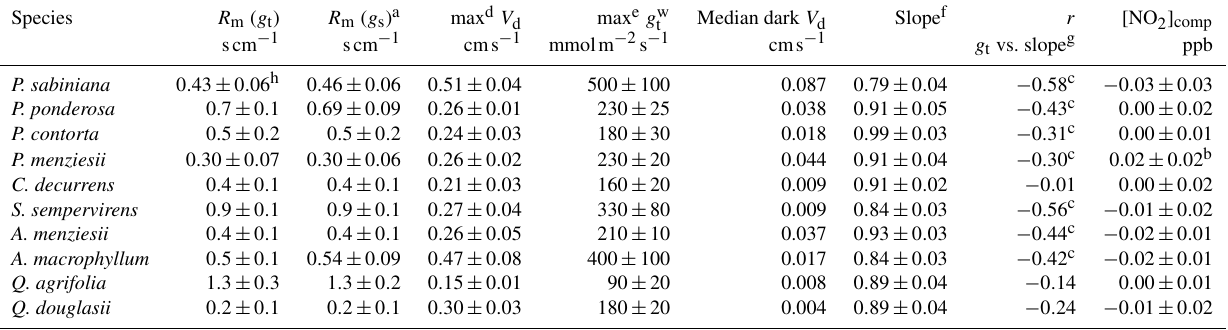
Table 2. Summary of species-dependent foliar deposition results. Species R m ( g t ) R m ( g s ) a max d V d max e g w t Median dark V d Slope f r [NO 2 ] comp scm − 1 scm − 1 cms − 1 mmolm − 2 s − 1 cms − 1 g t vs. slope g